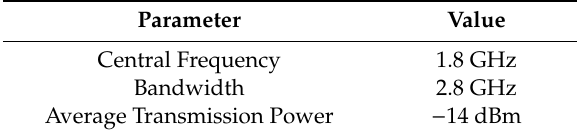
Table 1. NVA6100 Specifications.